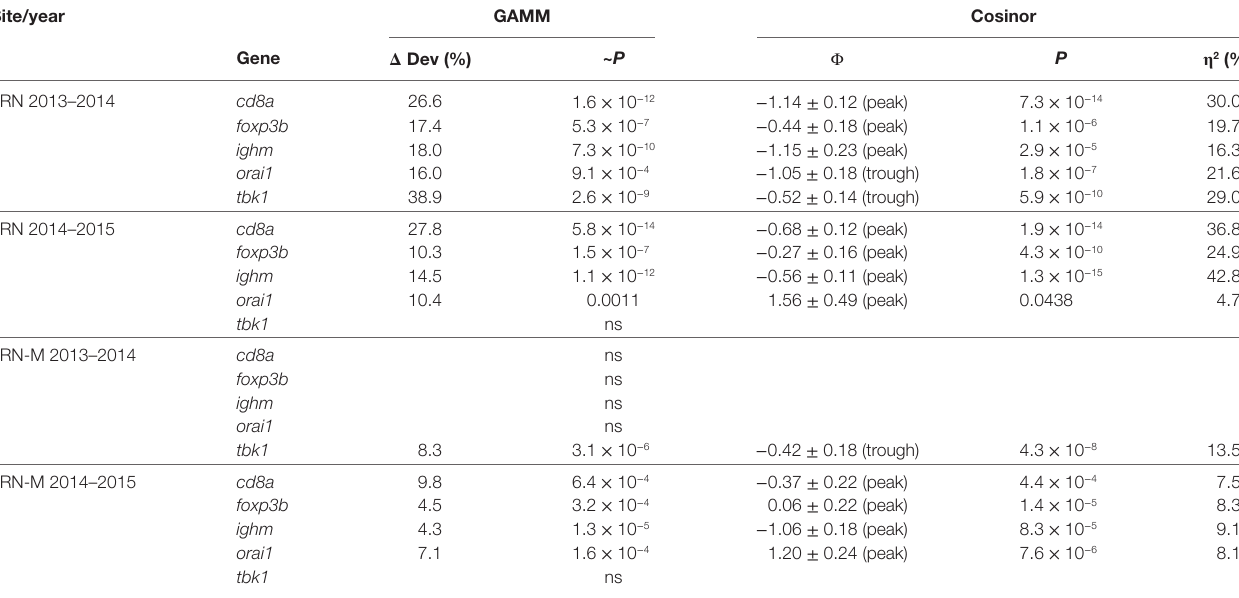
Results for non-parametric smoother time effects in generalized additive mixed models (GAMMs) and for sinusoid time effects in cosinor regression models. For GAMMs, Δ Dev is the reduction in deviance explained by the model, in percentage points, when the time effect is deleted. The approximate P values are based on Wald tests. For cosinor regressions the estimated acrophase ( Ф ) parameter is given ± SE, quantifying the timing of the sinusoid. The acrophase parameters give the distance (in radians) to the closest peak or trough (indicated in parentheses) to the baseline. Also given is the summed classical η 2 effect size for the cosinor (time) terms in the